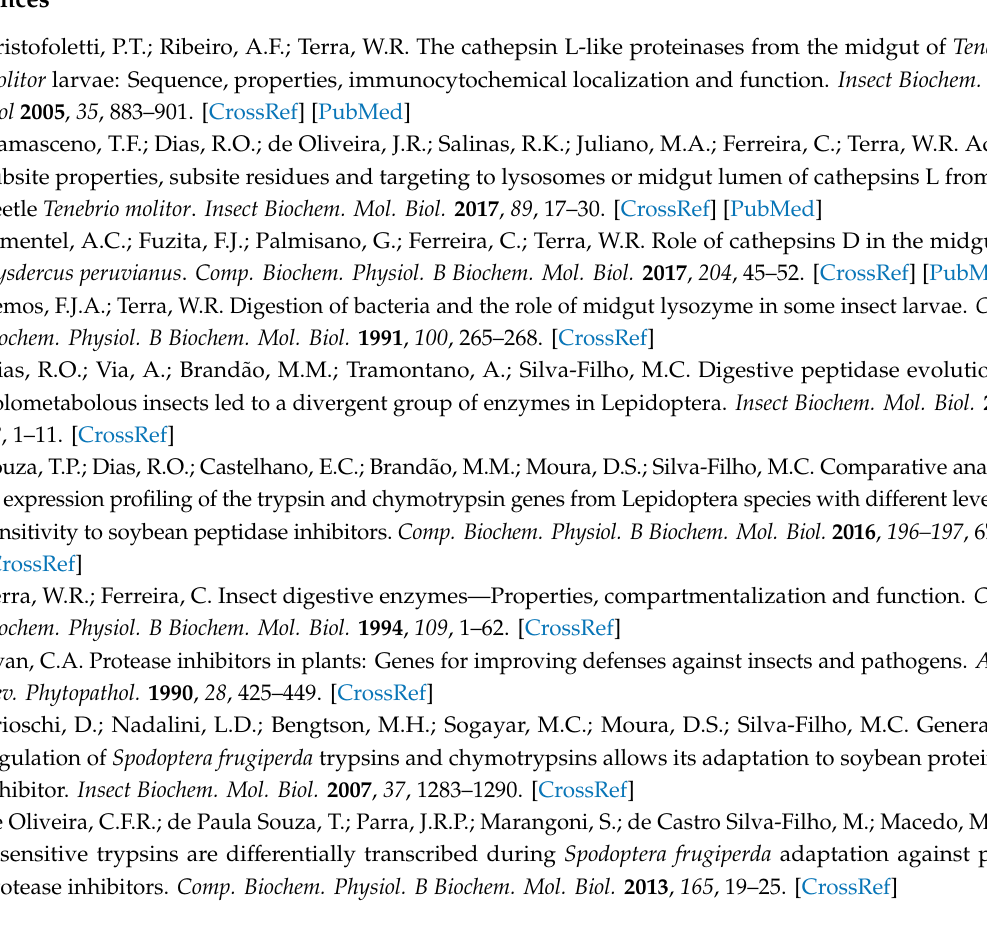
binding site consensus for each similarity group, Figure S4: Chymotrypsin-binding site consensus for each similarity group, Figure S5:BUSCO assessment results for the 23 Lepidoptera species protein datasets, Figure S6: Overview of the bioinformatic workflow used in the putative trypsin and chymotrypsin protein sequences annotation, Table S1: Distribution of the number of genes related to each trypsin similarity group by genome, Table S2: Description of the trypsin protein sequences grouped in each similarity group, Table S3: Distribution of the number of genes related to each chymotrypsin similarity group by genome, Table S4: Description of the chymotrypsin protein sequences grouped in each similarity group, Table S5: Other sequences with trypsin domains in the S. frugiperda transcriptome, Table S6: Number of sequences with an identified trypsin domain that were not classified as trypsin or chymotrypsin sequences for each analyzed